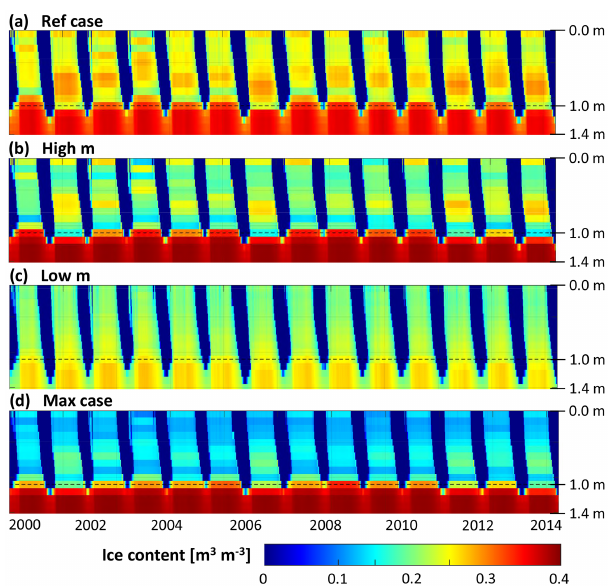
Figure 3. Ice content (m 3 m − 3 ) in the active layer and upper per- mafrost over the study period as simulated in four selected scenar-